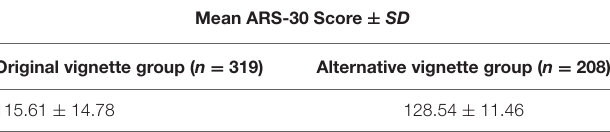
TABLE 9 | Mean global ARS-30 score by vignette group.